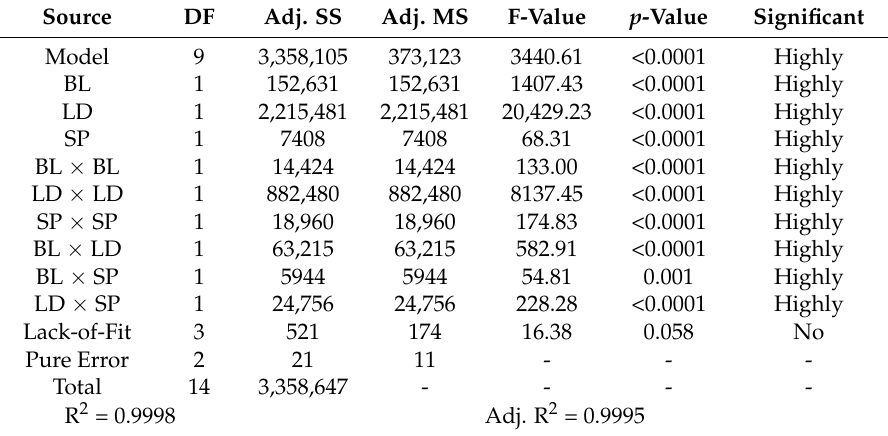
Table 10. ANOVA results of the interactive effect of biodiesel blends, load and speed on brake specific fuel consumption